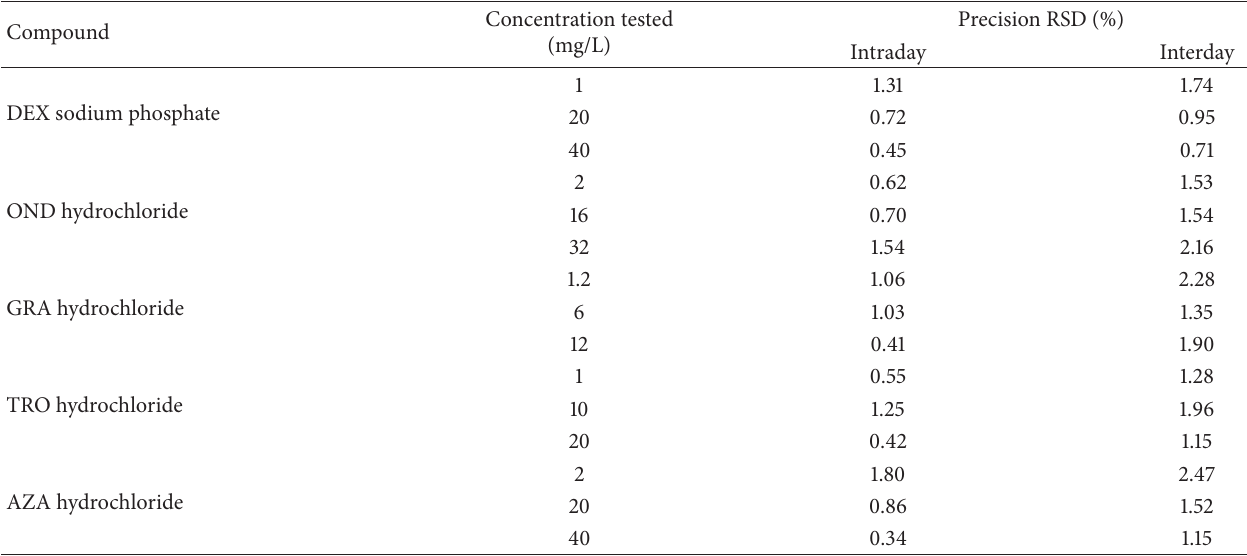
Table 2: Precision of the